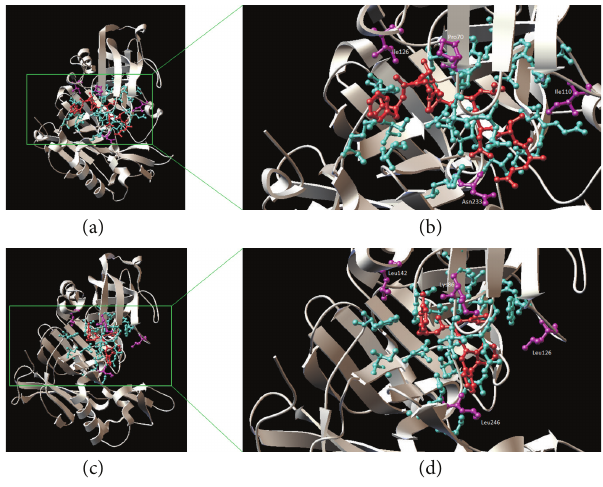
Figure 5: The display of ligand, conserved, and group-specific residueswithintheligandbindingsitsofBACE1(a,b)andBACE2(c, d). The ligands are coloured red while conserved and group-specific residues are coloured cyan and